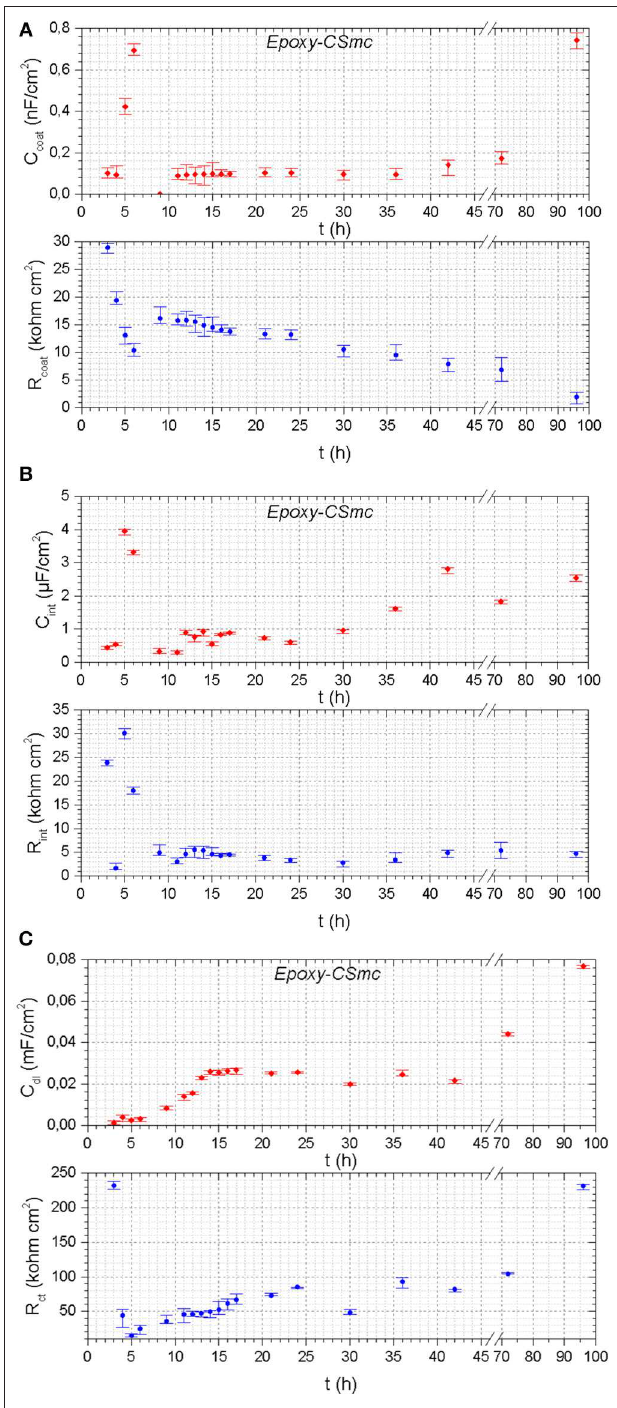
FIGURE 9 | The evolution of the EIS fitting parameters as a function of time of artificially scribed Epoxy-CSmc : (A) R coat , C coat ; (B) R int , C int ; (C) R ct , C dl .